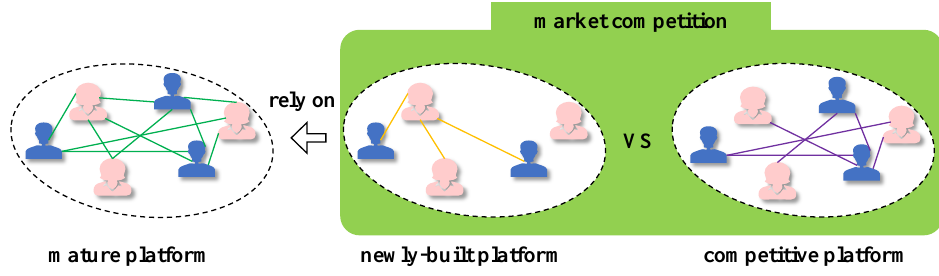
Figure 1. An example of the competition between two